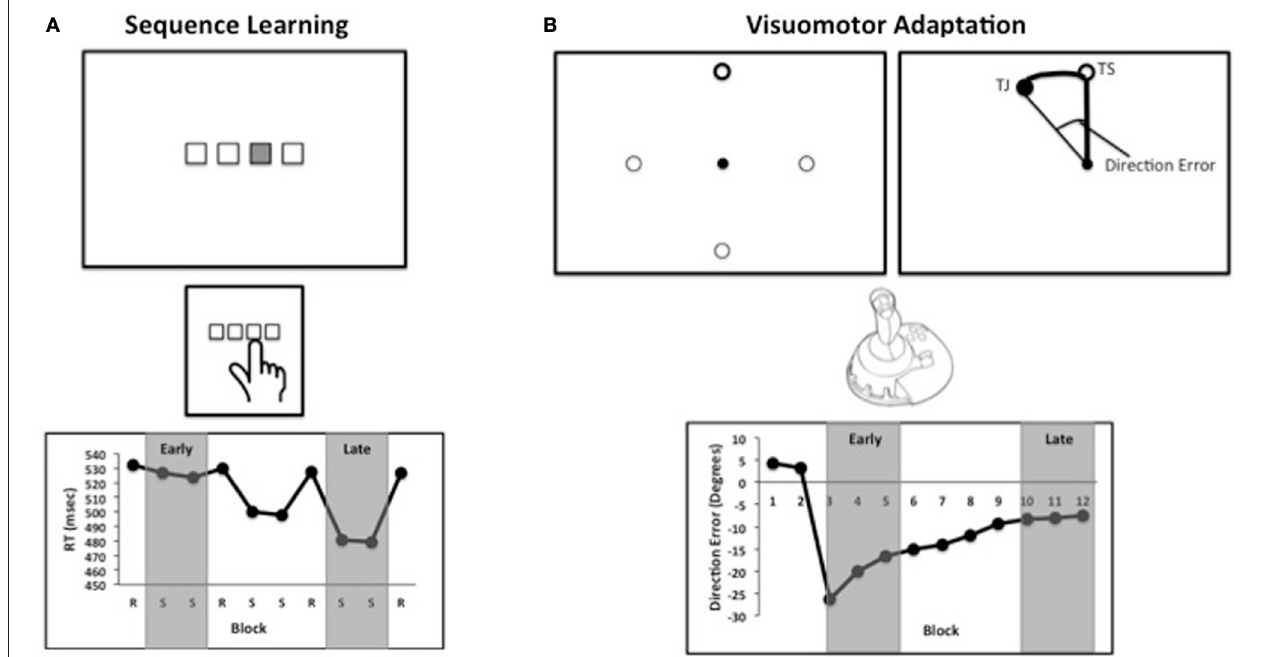
FIGURE 1 | (A) Schematic of a standard sequence learning task. Stimuli corresponding to buttons on a response box or keyboard are presented on a computer screen. The sequence is presented by highlighting a location, and the participant presents the corresponding button. Blocks alternate between sequence(S) presentations,and the presentation of locations in random order (R). (B) Aschematicofavisuomotoradaptationtask.Participantsarepresented with one of four targets on a computer screen, and are asked to move the cursor to the highlighted circle (top left). After several practice blocks, the feedback is rotated with respect to the participant’s movement. Participants